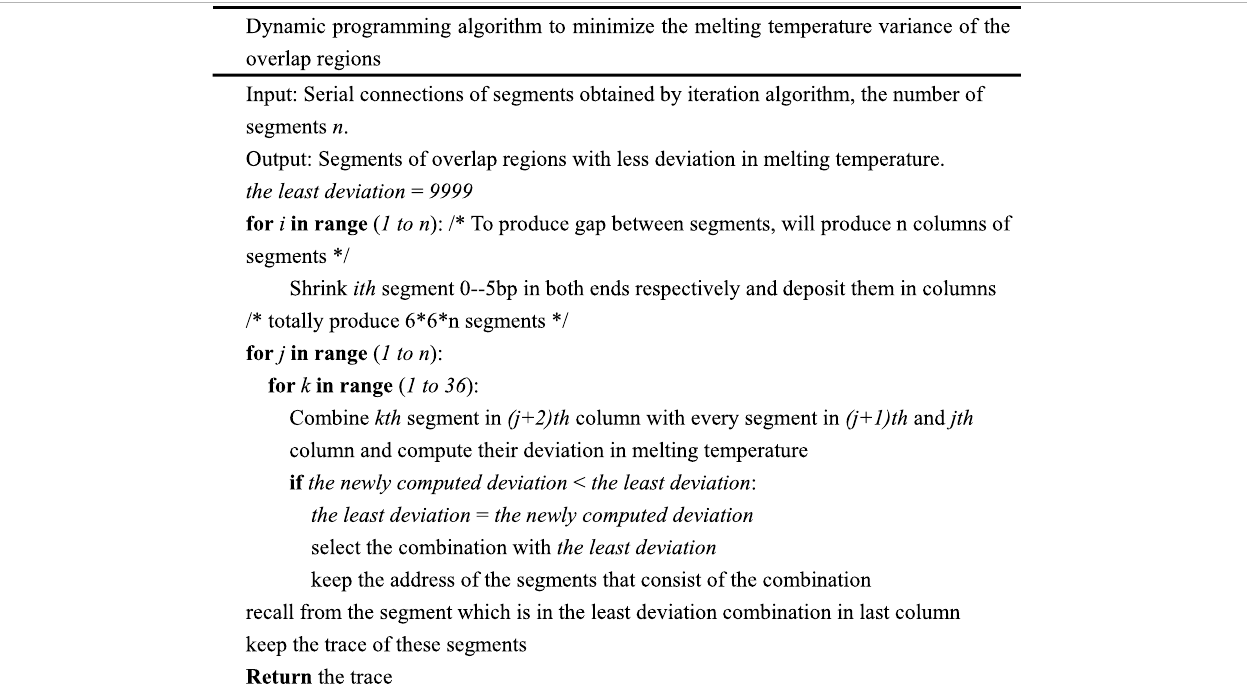
TABLE 3 | The dynamic programming